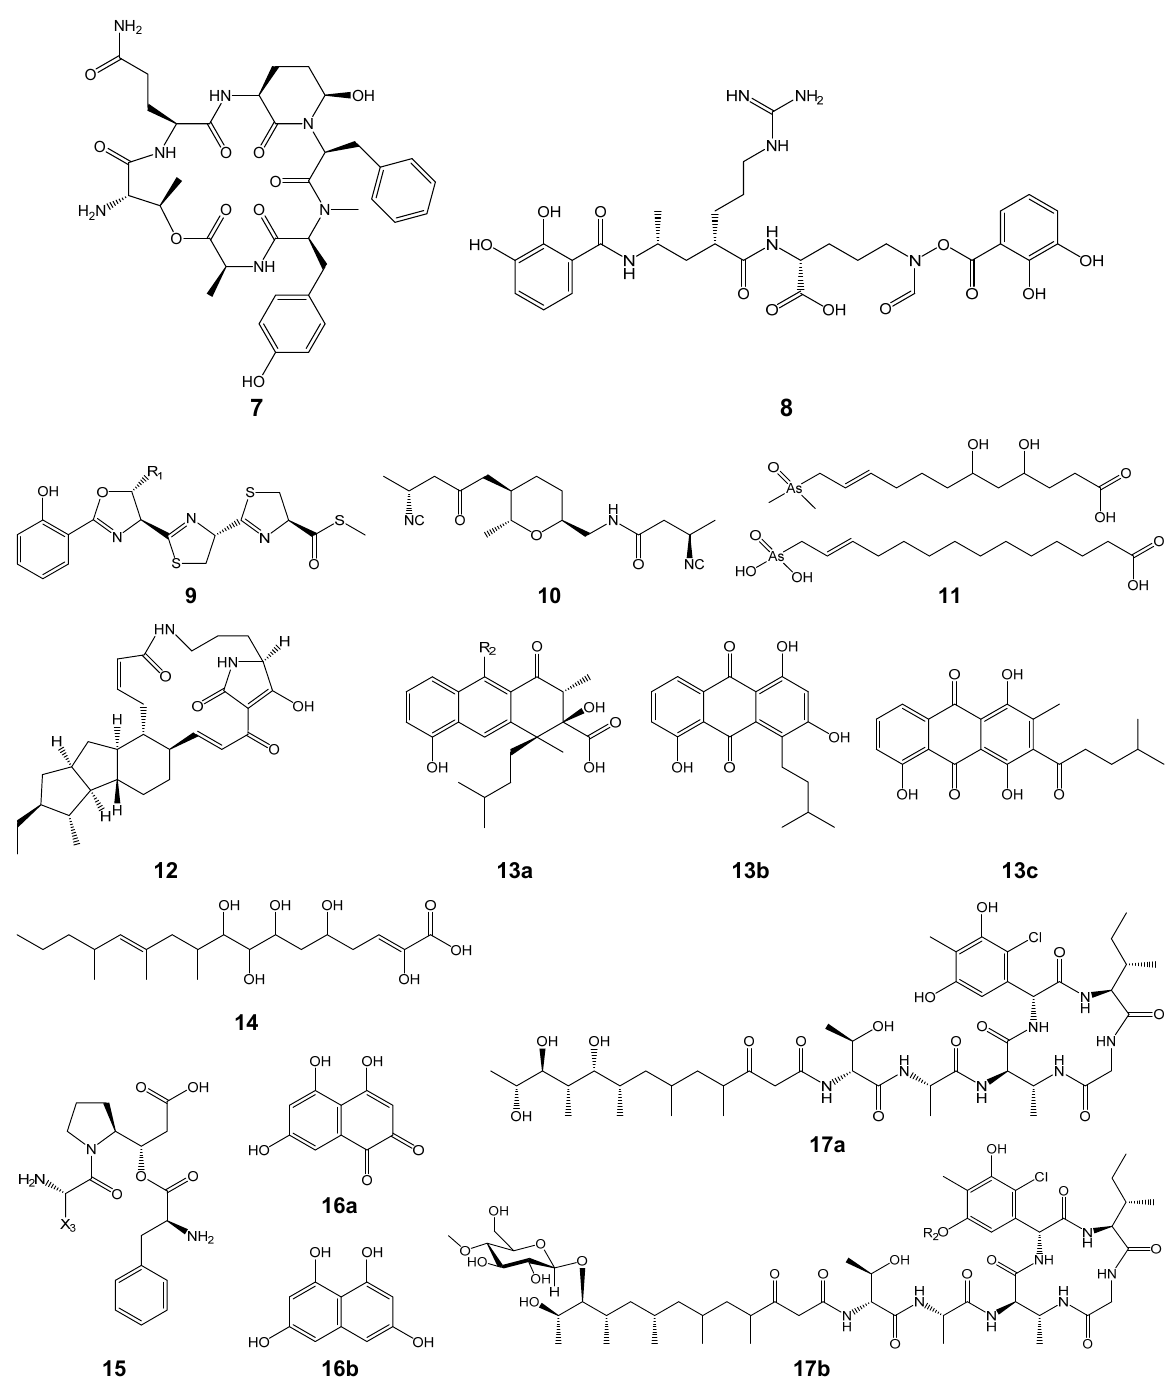
Figure 3. Chemical structures of 5 to 17 shown in Table 3. X 1 to X 3 , derived from unidentified amino acid residues; 5 , predicted decaketide according to the domain organization of t1pks-1 ; 6 , coelichelin [18]; 7 , putative streptopeptolin congener inferred from the domain organization of nrps-2 ; 8 , mirubactin [19]; 9 , coelibactin (R 1 = CH 3 or H) [18]; 10 , SF2768 [20]; 11 , arsono-polyketides [21,22]; 12 , pactamide [23]; 13a , rishirilides B and C (B, R 2 = H; C, R 2 = OH); 13b , lupinacidin A; 13c , galvaquinone B [24,25]; 14 , putative polyketide chain deduced from the domain organization of t1pks- 4 and considering the butyrolactol-biosynthetic pathway, but where the lactone ring forms is unclear; 15 , presumed putative peptide chain from the domain organization of pks/nrps-3 and considering the biosynthesis of rimosamide C; 16a , flaviolon; 16b , 1,3,6,8-tetrahydroxynaphthalene [26]; 17a , totopotensamide B; 17b , totopotensamides A and C (A, R 2 = H; C, R 2 = SO 3 H)